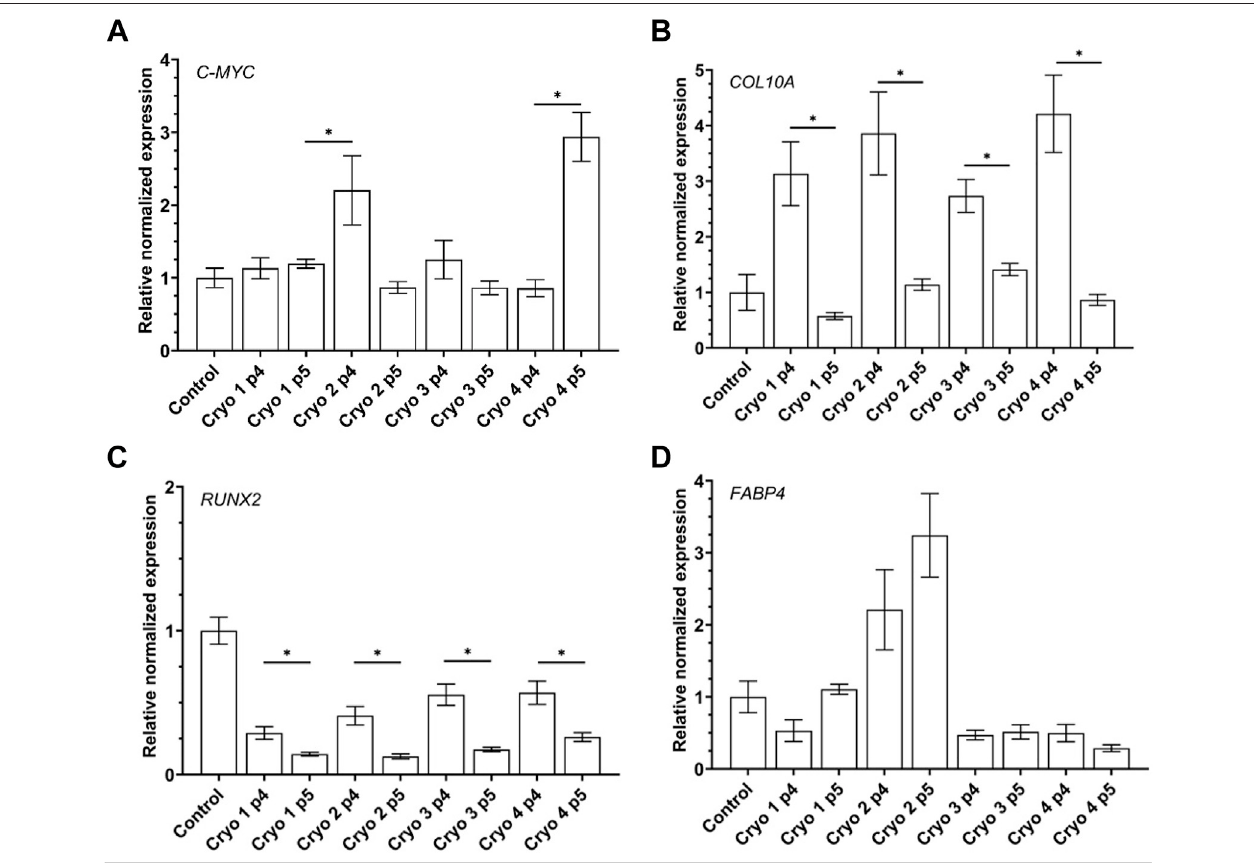
FIGURE 7 | Gene expression of pluripotency related gene C-MYC (A) and differentiation-related genes: chondrogenic COL10A1 (B) , osteogenic RUNX2 (C) , adipogenic FABP4 (D) of the non-frozen (Control) and frozen/thawed AT-MSCs obtained from passages 4 and 5. Mean values ± SEM are shown; * indicates statistical signi fi cance ( p < 0.05) of the differences between groups marked above with the horizontal solid line.